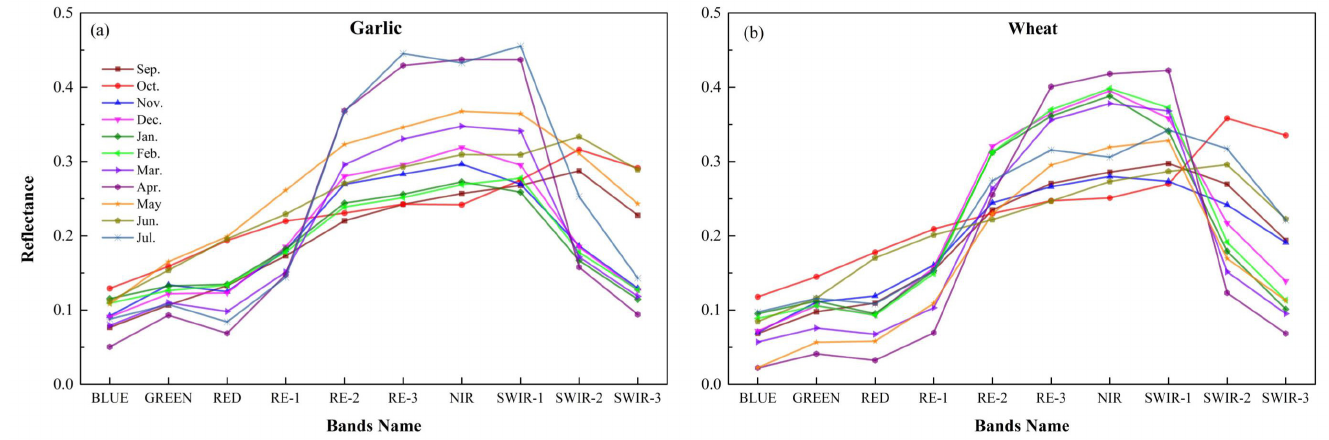
Figure 13. The reflectance of each month in various bands. ( a ) Garlic and ( b ) wheat. It is clear that the spectra of garlic and wheat are still distinct. In particular, the vegetation characteristics of garlic are not obvious in December, and February, whereas the spectral characteristics of wheat are obvious. This could be due to the phenology differences between garlic and wheat. Garlic sprouts later than wheat. During this period, wheat grows more vigorously than garlic, which is consistent with the conclusion that February (overwintering period) is the best month for garlic extraction in this study. In addition, it can be seen that the spectral difference between garlic and wheat in April is not obvious in Figure 13, while the RF method selected April (bolting period) as the best month to distinguish garlic and wheat, which was in accordance with earlier studies that choosing the image from bolting period significantly impacted the accurate separation of wheat and other crops (garlic) [14]. It is shown that the machine learning method has good performance and can select the best month, which cannot be selected by using the differ- ence of spectral curves between garlic and wheat. There are some limitations to selecting the best month of garlic extraction only by the difference of spectral curve. Using a ma- chine learning method can help us mine more information conducive to garlic extraction. 5.3. Uncertainty and Outlook The reference data constitute the basis for assessing the quality of the classification. Thus, these serve as verification that the research procedure performed was successful. Field investigation data have been widely used in crop extraction and mapping as reliable verification data [14,31], which will help us to assess whether the selected remote sensing data are proper for our purposes. However, because of the influence of weather and en- vironment, this study did not conduct field investigation, so it was unable to obtain ground data, which may have resulted in insufficient accuracy verification. As a result, in the following study, we will consider using ground investigation to obtain more accurate verification data. It should be noted that this study, we only used the spectral reflectance of the image to extract the planting area of garlic. For other crops (winter wheat, corn and soybean, etc.) whose growth cycle overlaps with garlic, we can consider using more features to extract garlic planting area, such as vegetation index, texture information, or other addi- tional features. The vegetation index can mitigate the effects of the atmosphere, terrain, and thin clouds [52,53]. Some studies also demonstrated that spatial features such as tex- ture information could effectively improve extraction accuracy when using mono-tem- poral images [54,55]. However, because this study focused on which band and which